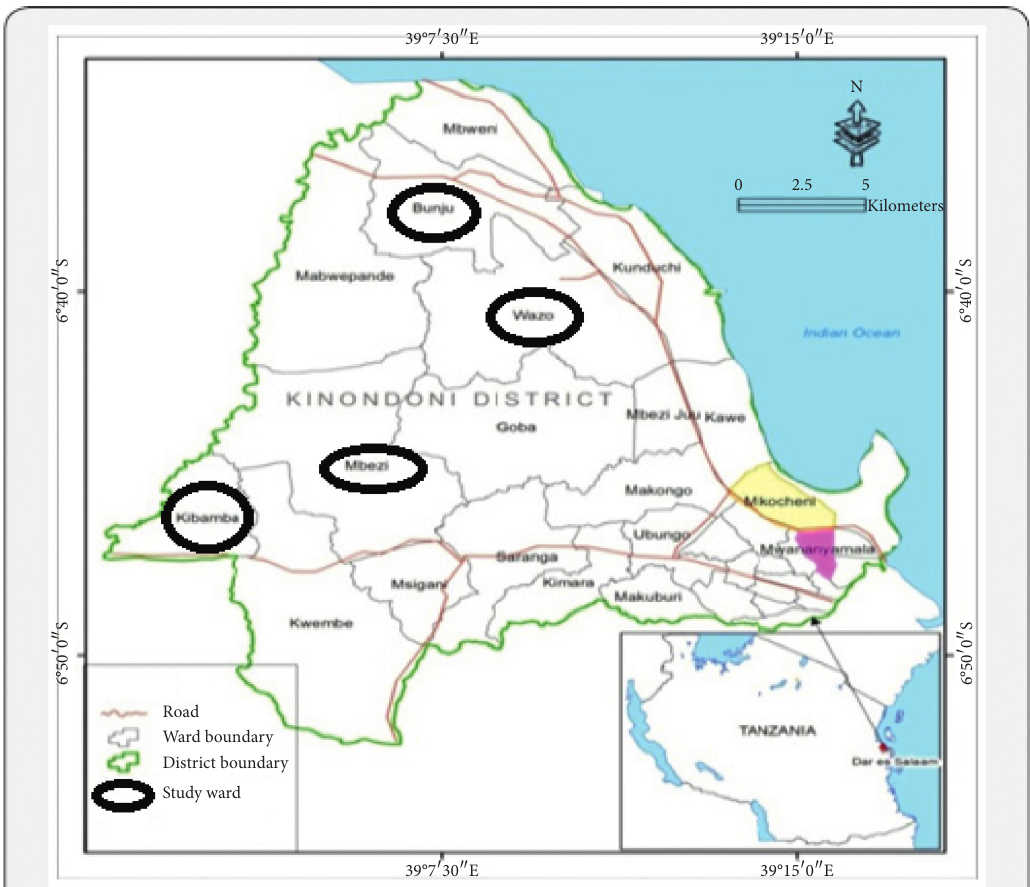
Figure 1: Map showing Kinondoni Municipality, location, and names of wards included in the study. Source: USDM IRA-GIS Unit